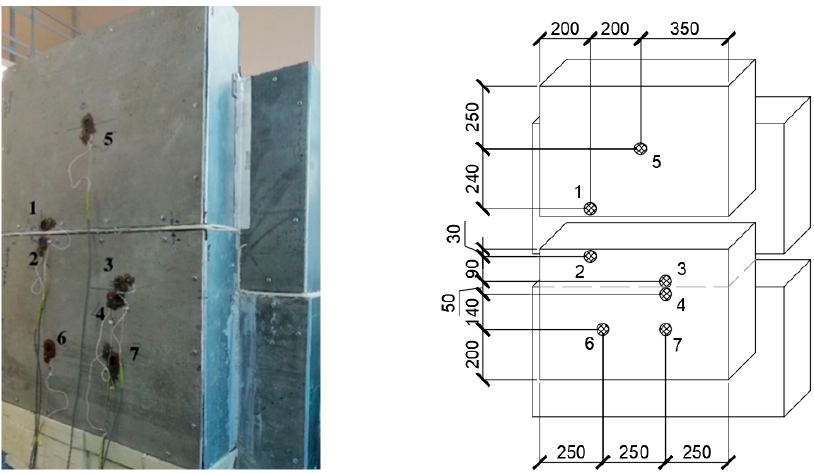
Figure 9. Sample No. 2 with installed thermal and temperature sensors. Based on the data obtained, the most temperature-stabilized estimated time intervals were selected, and graphs of temperature on the specimen No. 2 surface versus time and of heat flow versus time were plotted (see Figures 10 and 11).